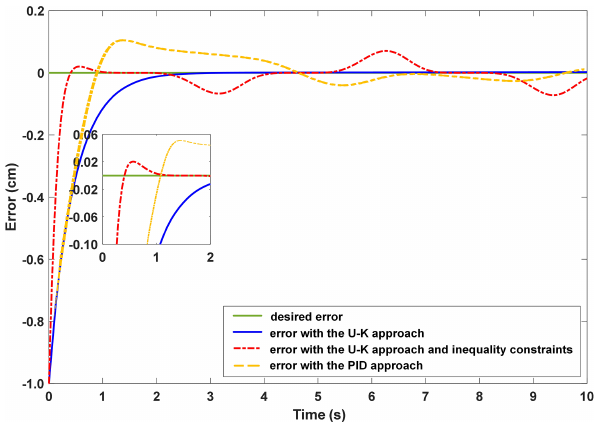
Figure 5. PMLM error under the sinusoid